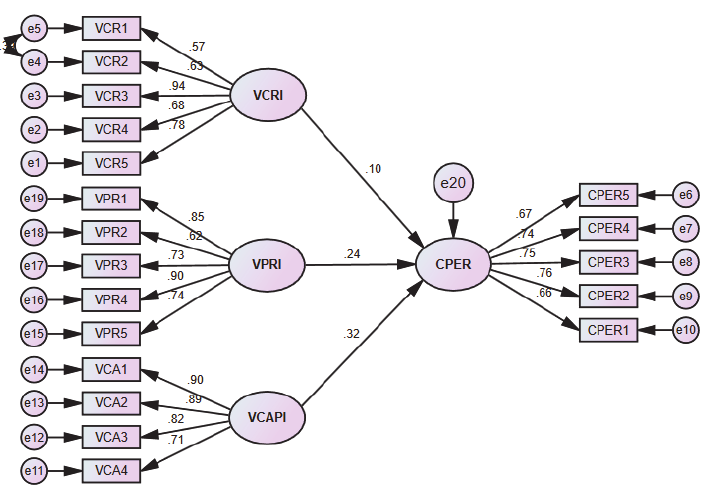
Fig. 3. Research structural model